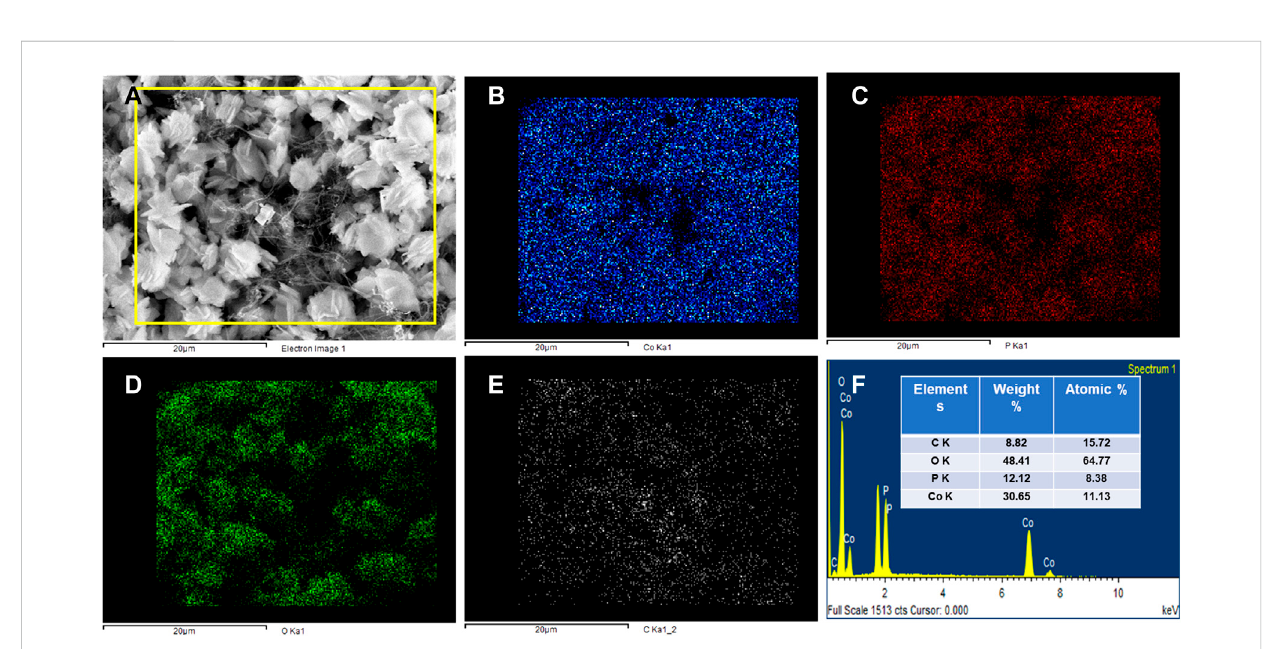
FIGURE 5 (A) Mapping selected image. (B) Mapping of Co, (C) P, (D) O, (E) C, and (F) EDX of the Co 3 (PO 4 ) 2 .8H 2 O/CNF composite fl